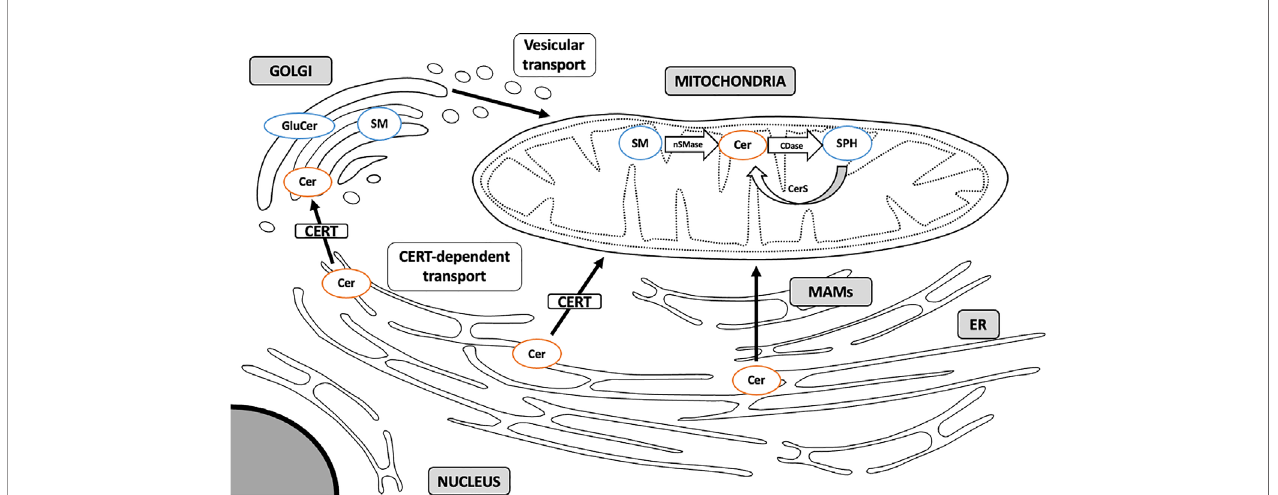
FIGURE 2 | Sphingolipid transport to mitochondria. Sphingolipids are synthesized mainly through a de novo pathway located in ER. Complex sphingolipids are synthesized in Golgi membranes and travel to various intracellular compartments via vesicular transport. Ceramide can also translocate to the mitochondria directly through membrane contact sites at the MAM interface or through CERT-dependent mechanism. MAM, mitochondria-associated membranes; ER, endoplasmic reticulum; SM, sphingomyelin; Cer, ceramide; GluCer, glucosylceramide; SPH, sphingosine; CERT, ceramide transfer protein; nSMase, neutral sphingomyelinase; CDase, ceramidase; CerS, ceramide synthase. Arrows denote major routes of sphingolipid transport to